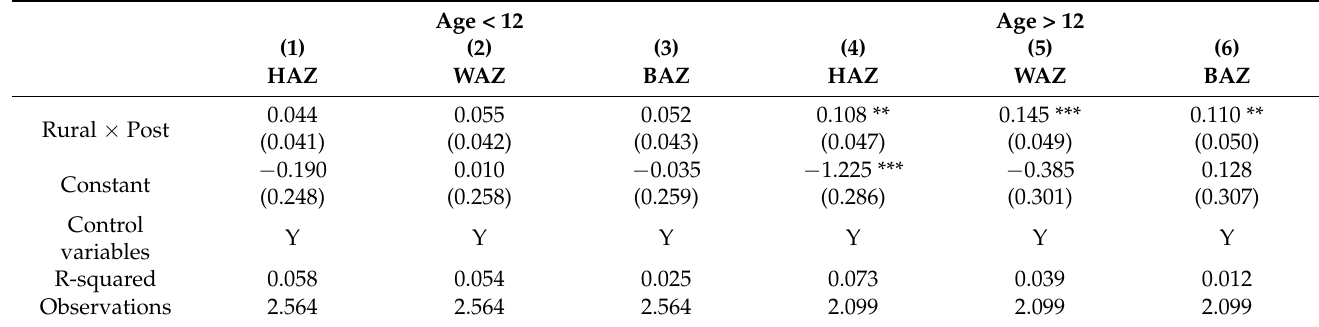
Table 6. Household technology and child health status: age heterogeneity.